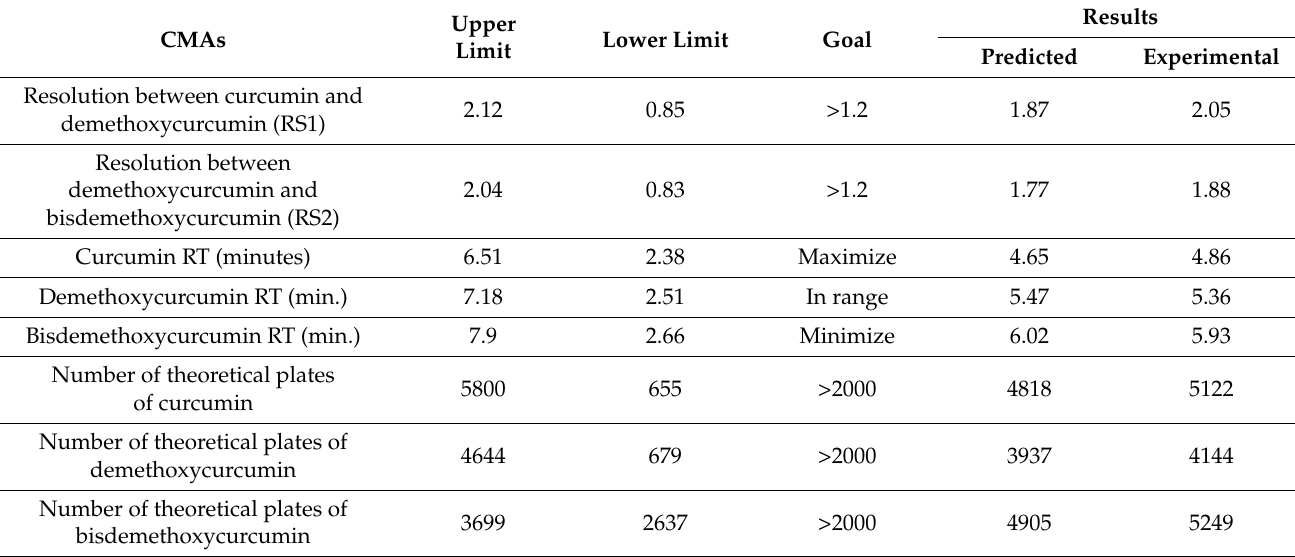
Table 3. The optimization standards for each